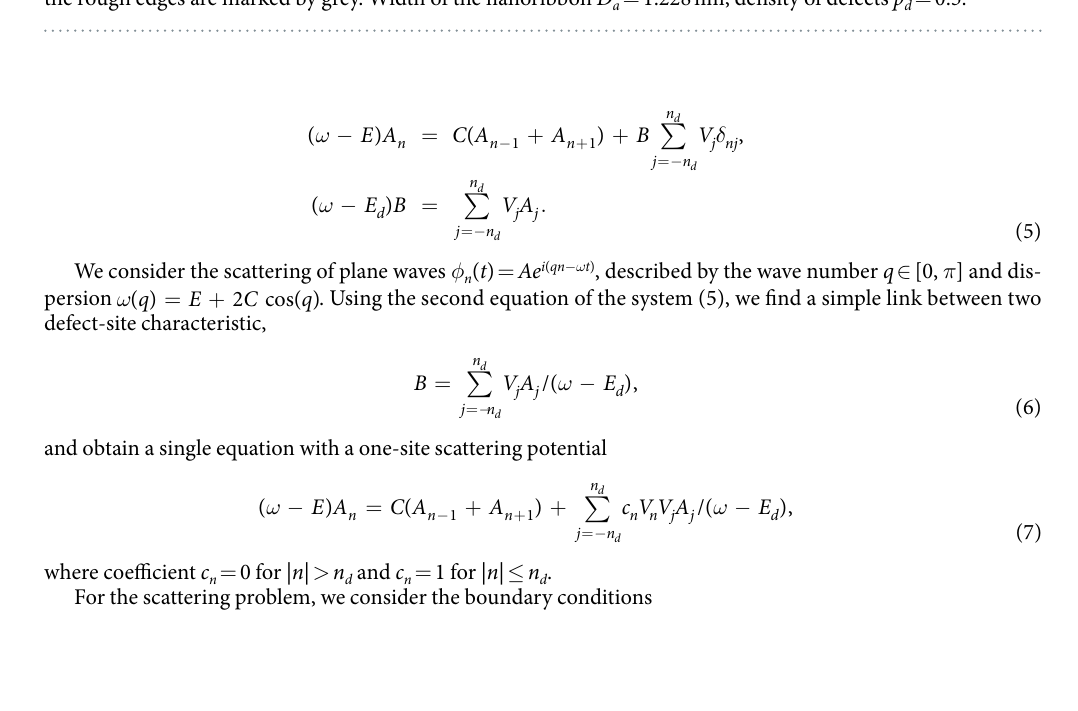
Figure 4. Example of an armchair carbon nanoribbon with rough edges in its central part. Edge defects creating the rough edges are marked by grey. Width of the nanoribbon D a = 1.228 nm, density of defects p d =